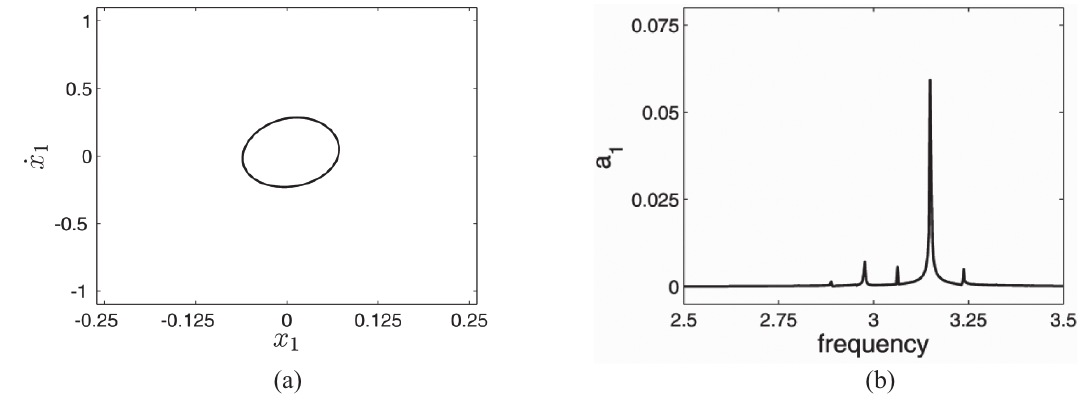
Fig. 13. Poincaré map (a) and fast Fourier transform (b) of the beam response; x 0 = 0.01, Ω = 3.06309, α 2 = 0.00306, α 1 =